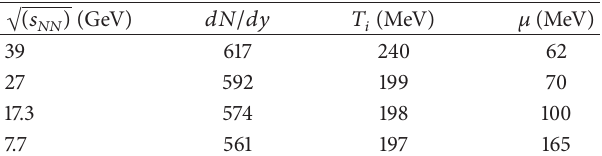
Table 1: The values center of mass energy √𝑠 𝑁𝑁 , 𝑑𝑁/𝑑𝑦 , initial temperature ( 𝑇 𝑖 ), and quark chemical potential used in the present